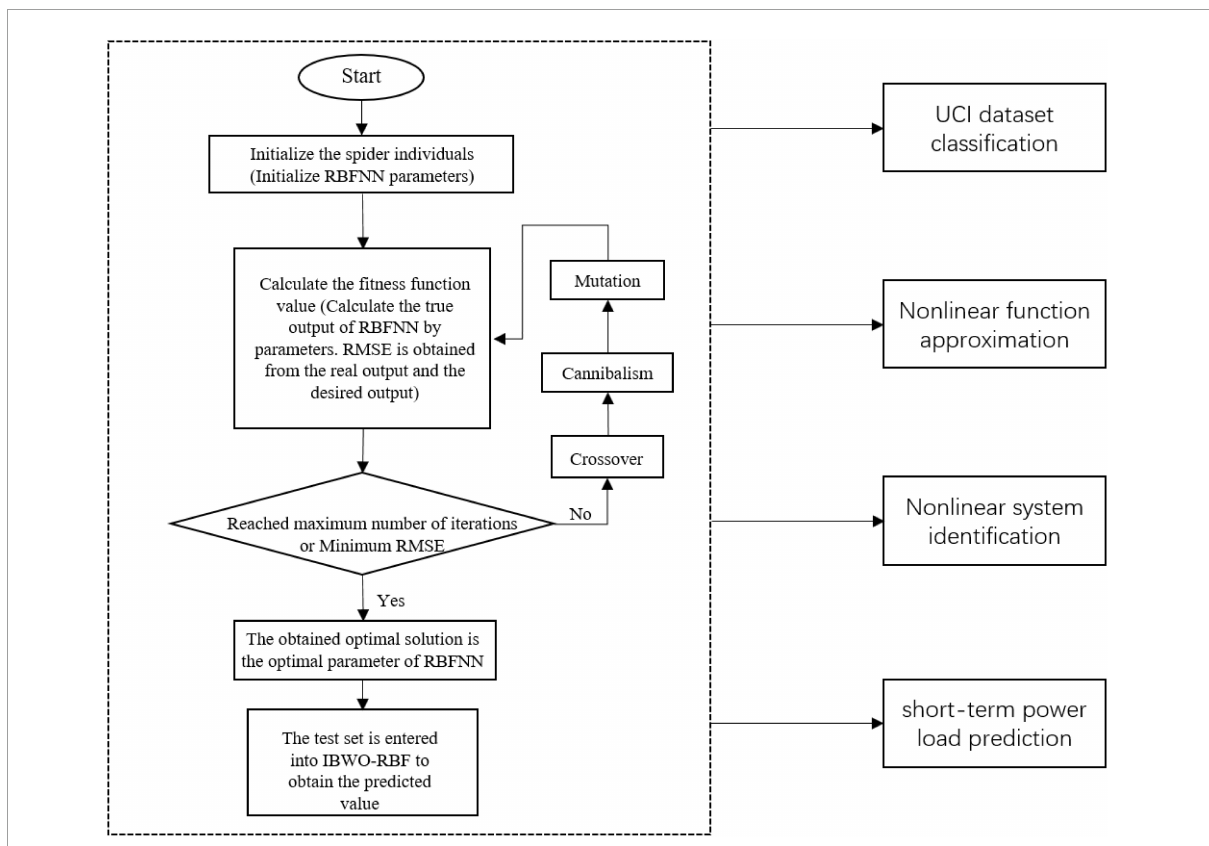
FIGURE4 System architecture of the improved black widow optimization algorithm (IBWO)-RBF model.